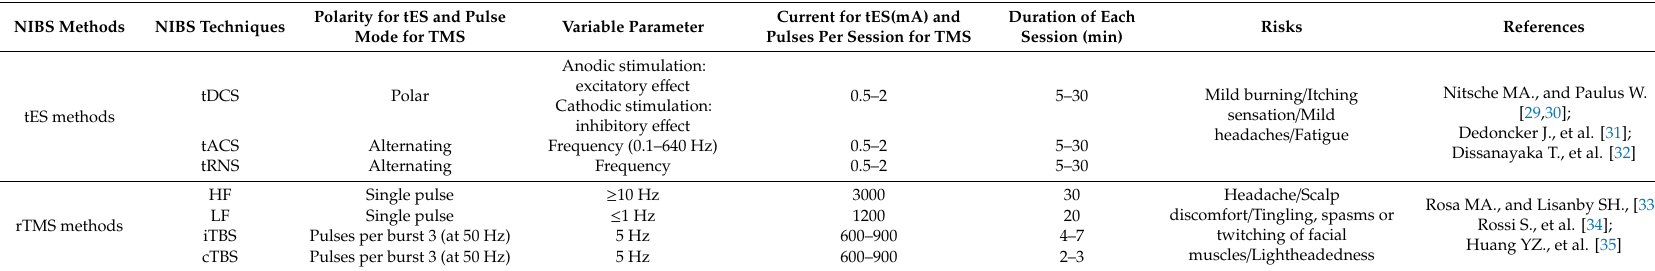
Table 1. Summary of methodological characteristics, stimulation parameters, and potential risks associated with transcranial current stimulation (tCS) and transcranial magnetic stimulation (TMS)